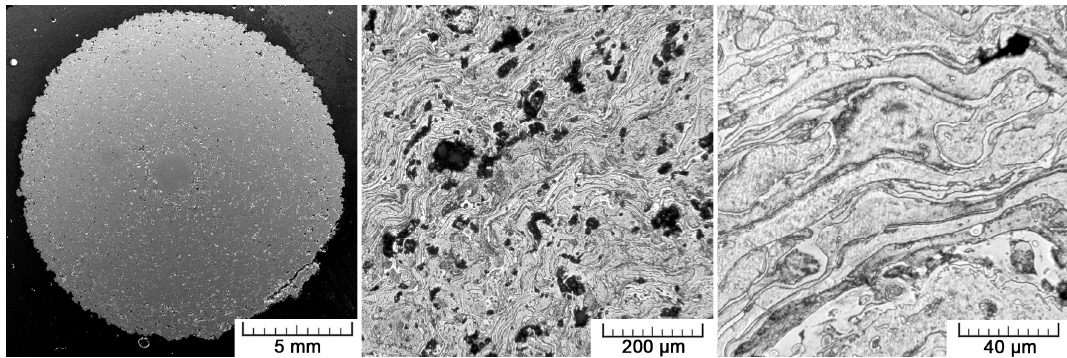
Figure 3. The structure of plasma-sprayed Ti from the macro - to the micro - scale .